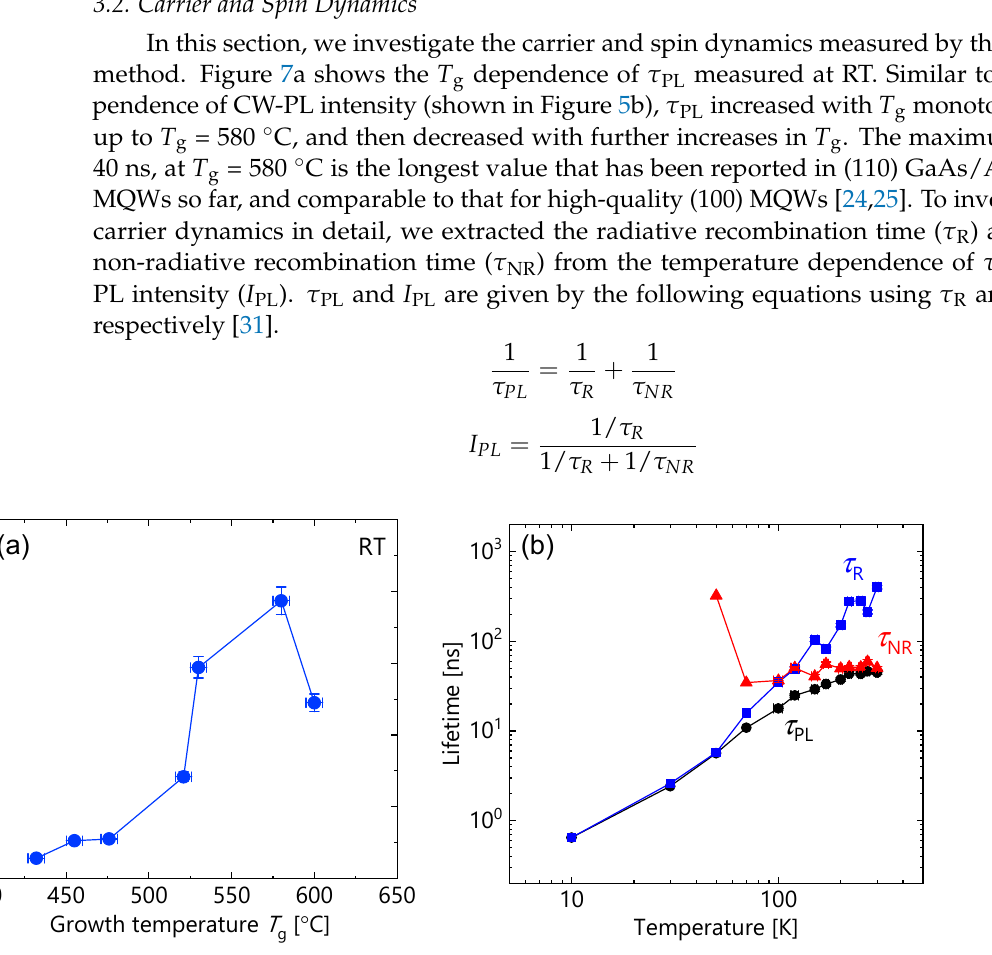
Figure 6. Cross-sectional transmission electron microscope (TEM) image for the sample grown at T g = 600 °C. The scan area is beneath the apex of the triangular pattern observed in Figure 3h. In the striped pattern, dark (light) gray areas represent AlGaAs (GaAs) layers. The observed stacking fault is along the <111> direction.